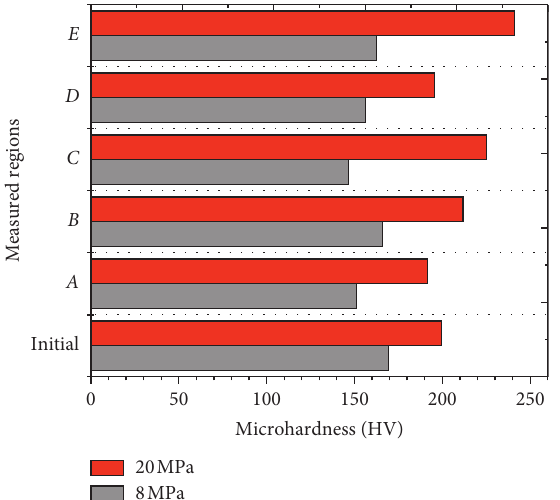
Figure 12: Microhardness distribution of the formed component in the cold-rolled state.